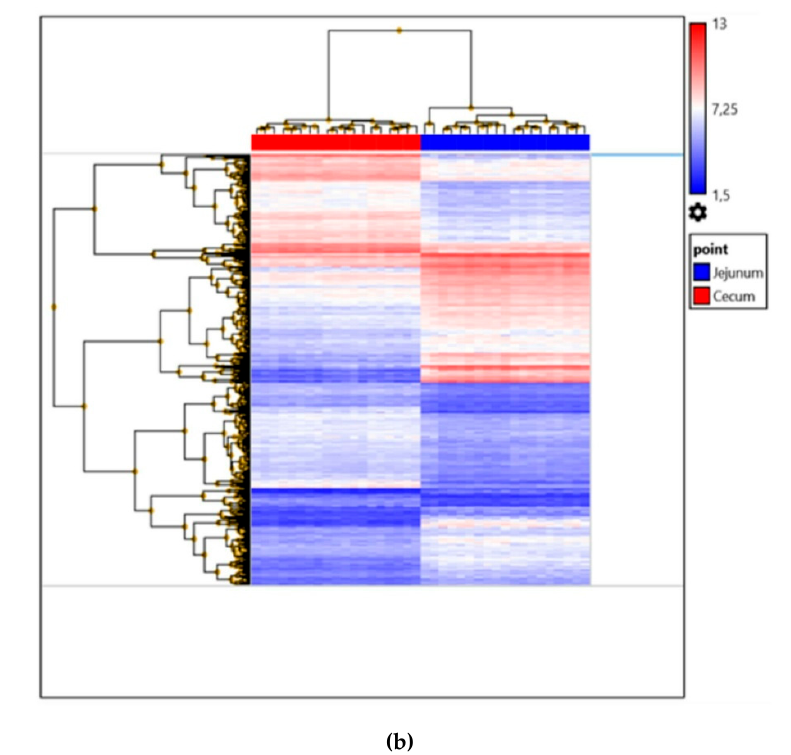
Figure 1. ( a ) Volcano diagram (jejunum in green color, cecum in red color), and ( b ) hierarchical clustering showing the distribution of differentially expressed transcripts (DETs) in the jejunum and cecum of broiler chickens (jejunum in blue color, cecum in red color). Transcripts were considered as DETs when showing a ≥ 2-fold change ratio (FCR) and a false discovery rate p -value (FDR) < 0.05 between tissues.